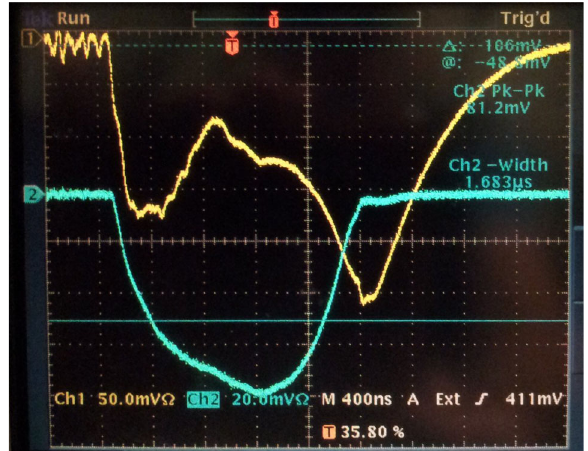
FIG. 14. Samples of monitoring signals during conditioning: cyan forward power, yellow reflected power.